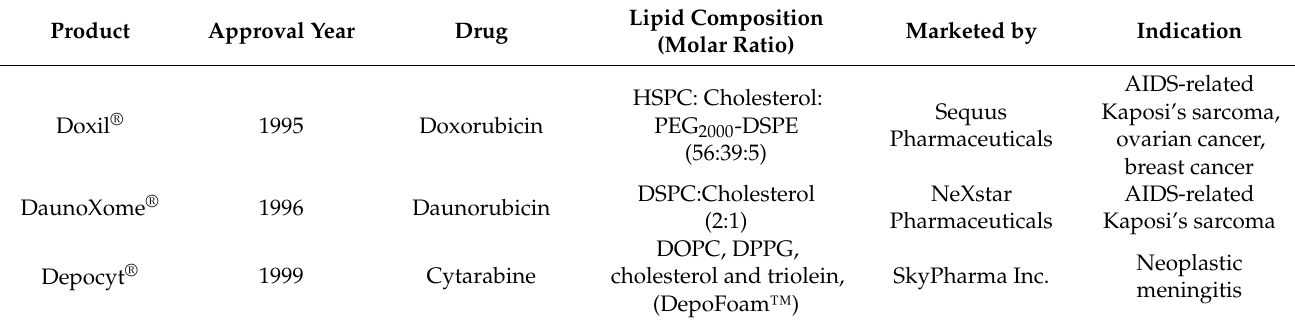
Table 1. Clinically used liposomal systems for cancer therapy